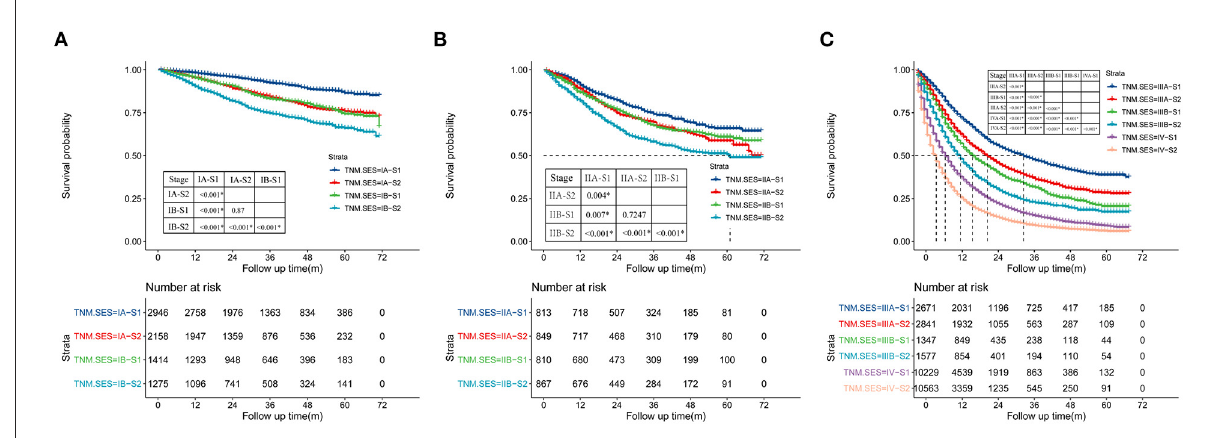
FIGURE3 Kaplan-Meier curves of cancer-specific survival (CSS) of the patient with NSCLC in each TNM (tumor node metastasis)-SES (socioeconomic status) stage, and (A) for TNM IA, IIB, (B) for IIA, IIB, (C) for IIIA, IIIB, IV.